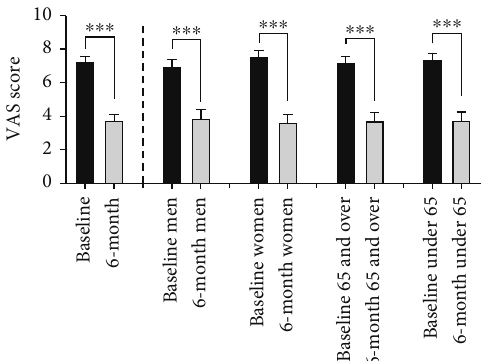
Figure 3: PGIC scores at 6 weeks and at six months postprocedure. The PGIC scores were signi fi cantly improved at 6 months postprocedure as compared to 6 weeks in the total patient population (left columns). When broken into subgroups (men, women, patients < 65 , and patients ≥ 65 ), all subgroups showed signi fi cant improvement as well ( ∗∗∗ p ≤ 0 : 0001 ; ∗∗ p ≤ 0 : 001 ; and ∗ p ≤ 0 : 01 across all groups including men ( 3 : 73 ± 0 : 38 to 4 : 41 ± 0 : 43 , p knees ), and patients < 65 years of age ( 4 : 24 ± 0 : 3 9 to 4 : 99 ± 0 : 36 , p < 0 : 0001 , and n = 80 knees ) (Figure 3). Interestingly,